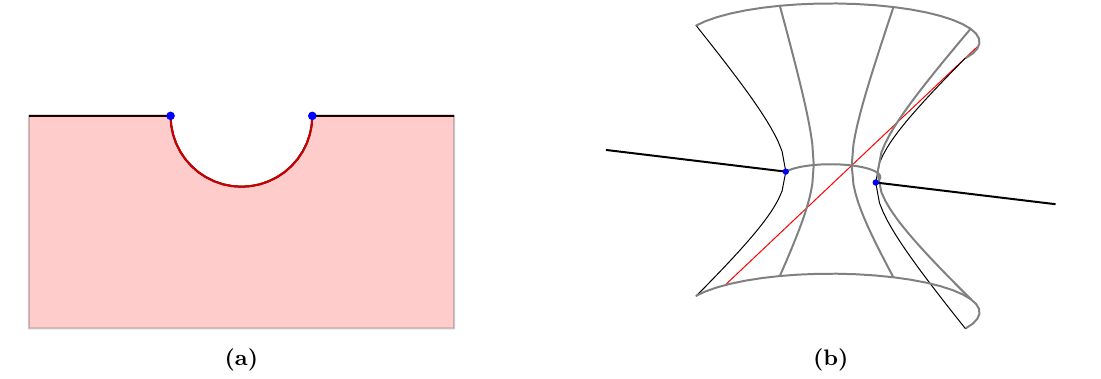
Figure 5. (a) Euclidean path integral for an entangled state of two BCFTs approximating the vacuum state of the parent CFT. (b) Lorentzian gravity dual for this state. The ETW brane is anchored on the CFT boundaries (blue dots), and forms a hyperbola in the bulk. By coupling the CFT boundaries we hope to find a causally connected bulk geometry. The null curve running along the black hole horizon is shown in